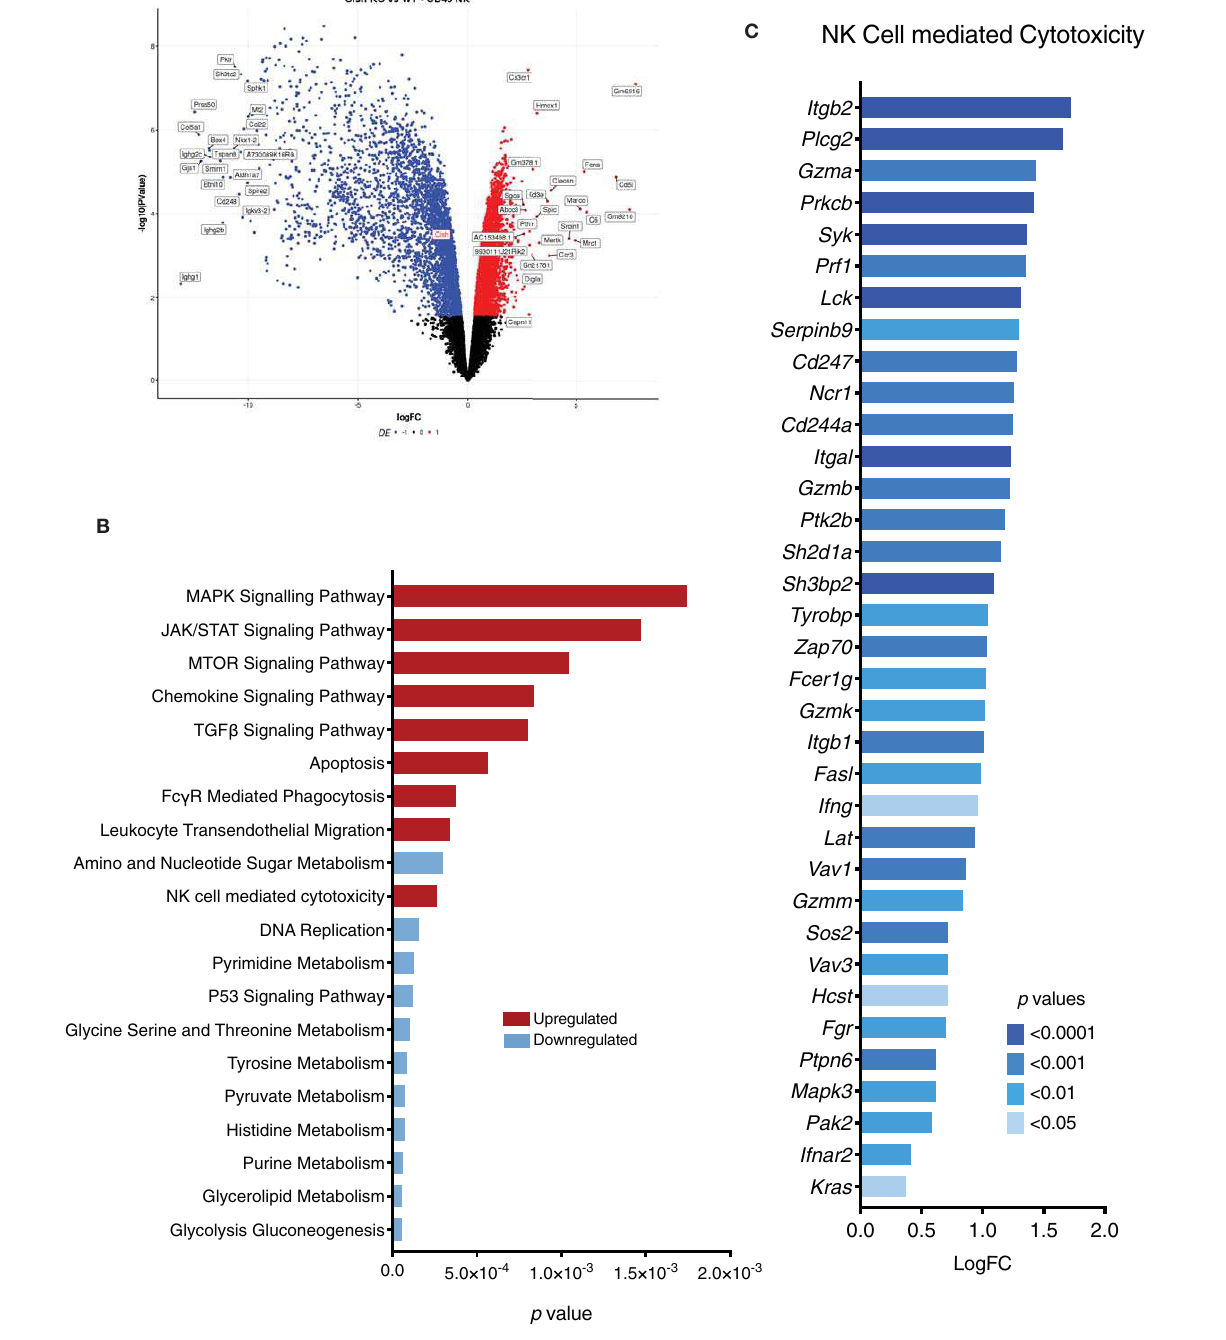
Frontiers in Immunology |